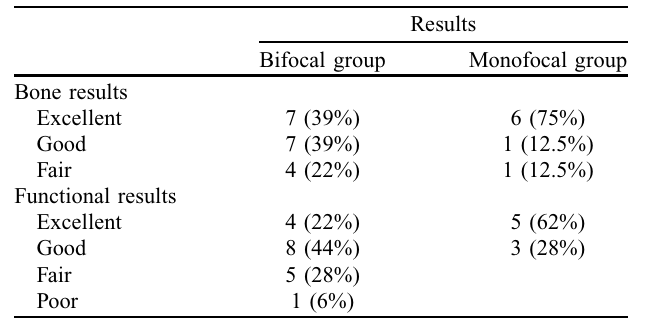
Table 2. Results.